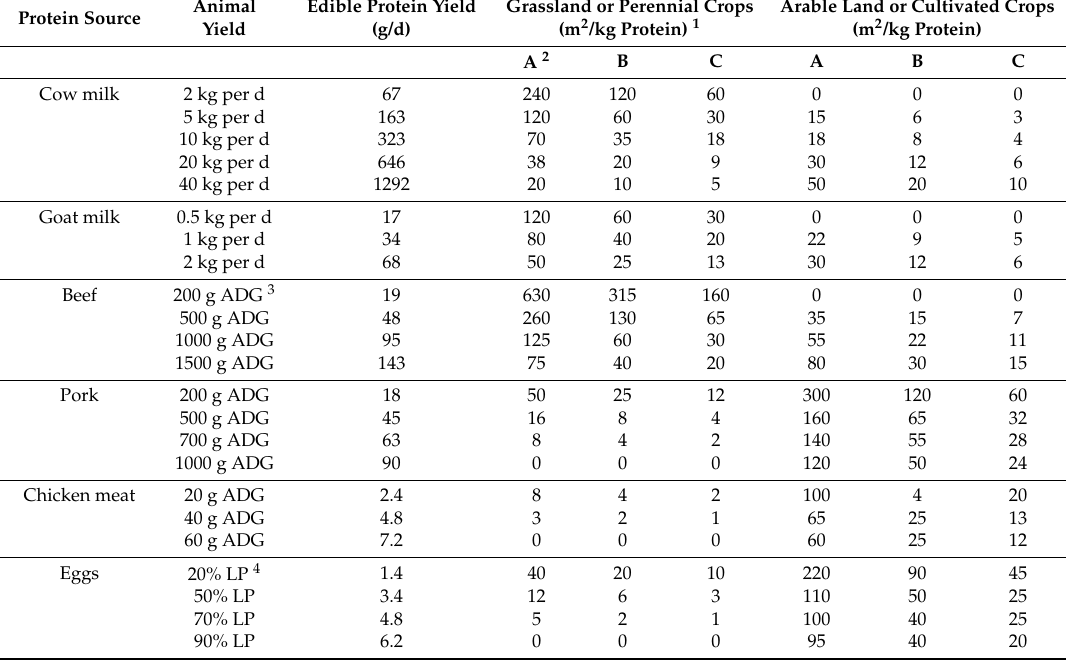
Table 6. Model calculations for land use per kg of edible protein depending on animal species/categories, plant yields, and animal performances (for forage to concentrate ratio see Table 4; all concentrates from arable land, no co-products